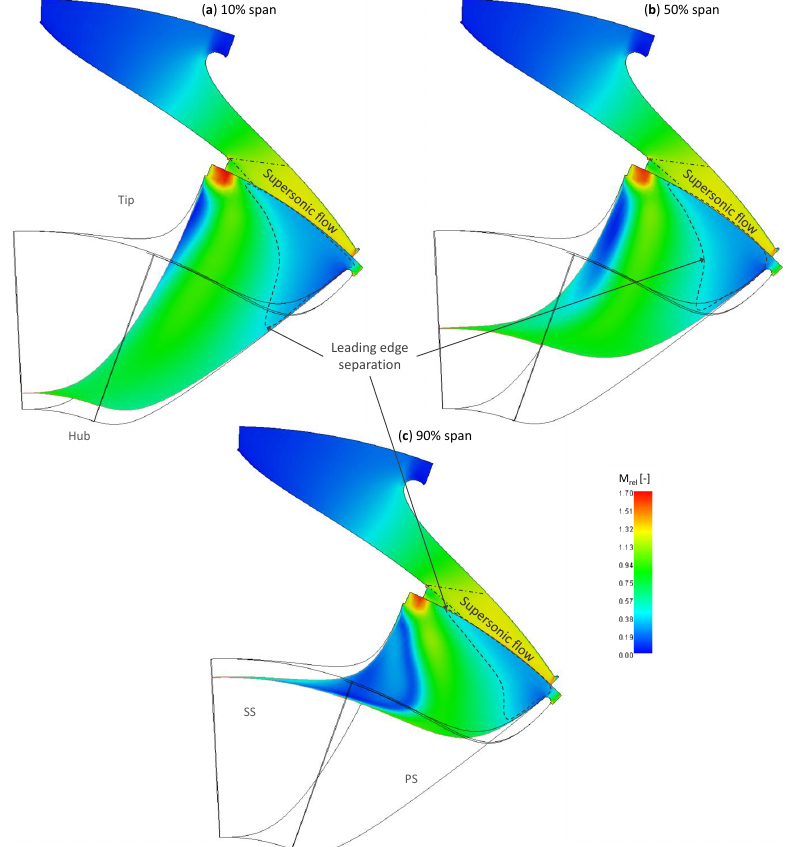
Figure 5. Relative Mach number distribution at three spanwise turbine passage locations: ( a ) 10% span, ( b ) 50% span, ( c ) 90%